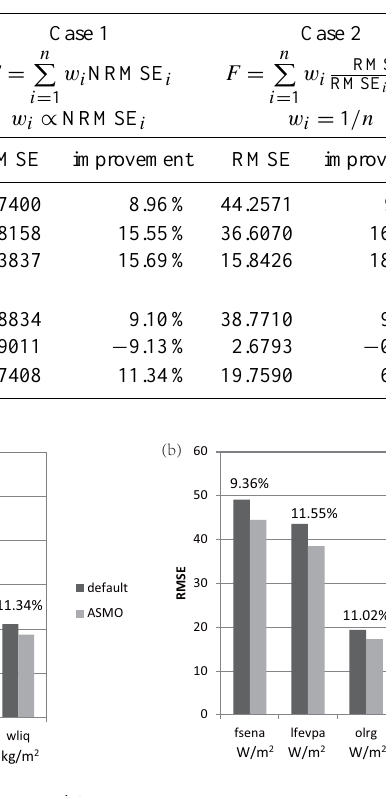
Figure 5. Comparing the improvements given by ASMO and